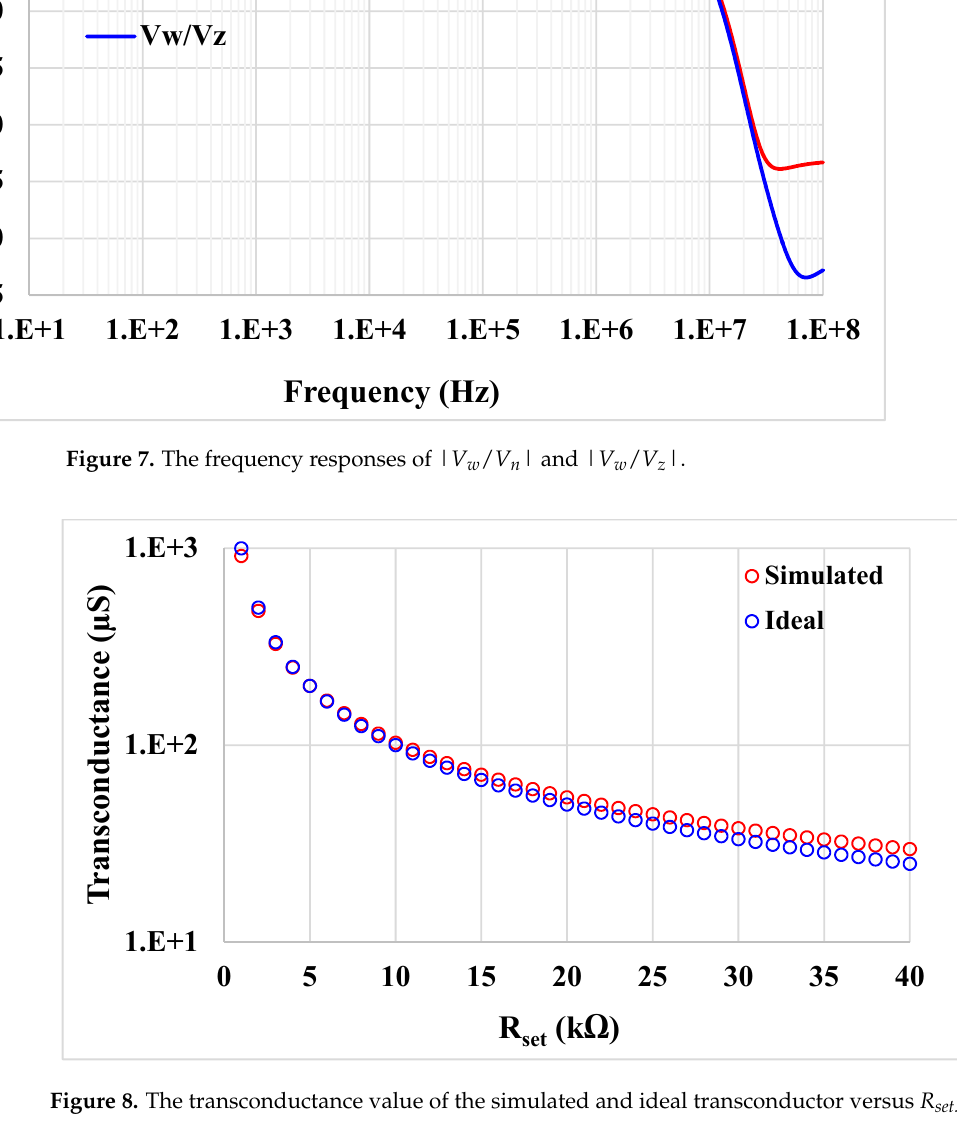
Figure 8. The transconductance value of the simulated and ideal transconductor versus R set.